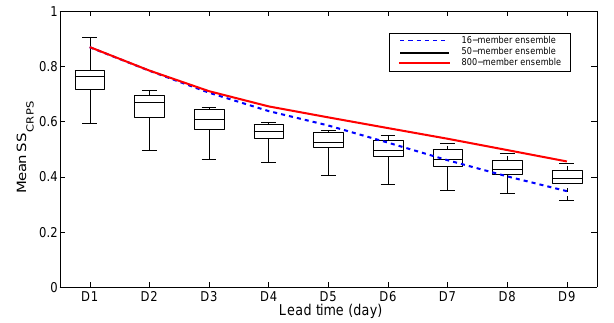
Fig. 4. Mean SS CRPS as a function of lead time for the 29 studied catchments and three types of ensemble